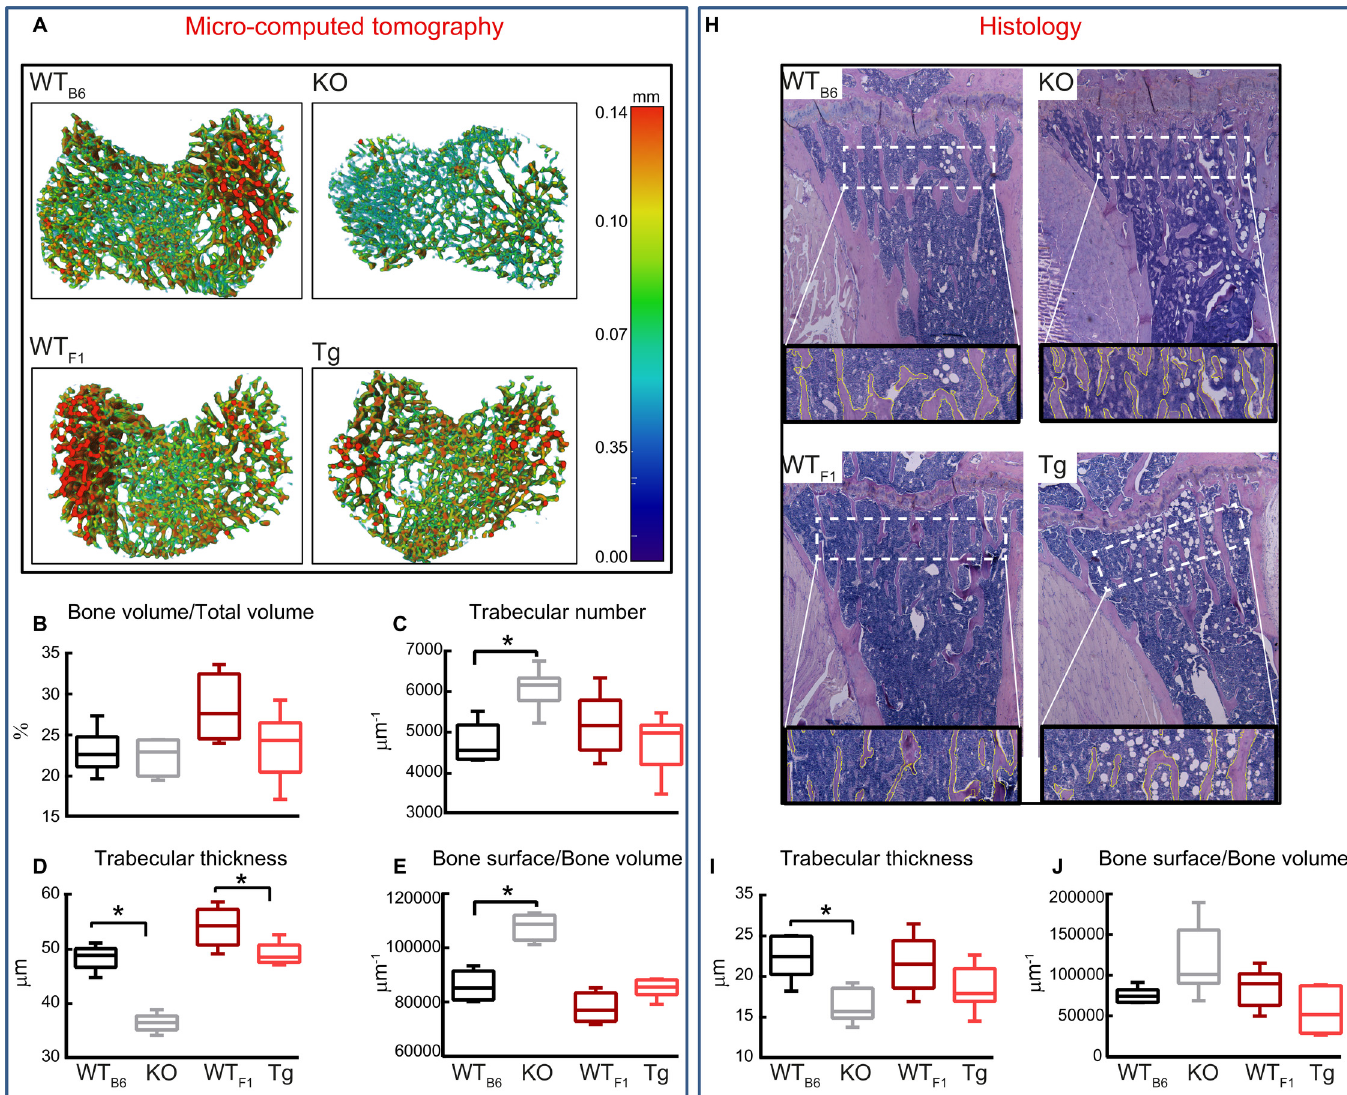
Fig 1. Deficiency and also transgenic overexpression of Timp-3 generate defects in trabecular bone. Trabecular bone phenotype of WT B6 (black), Timp-3 Tg (light red) tibia at 8 weeks of age. ( A ) Representative 3D Micro-CT thickness colour-coded images of tibial Timp-3 KO (grey), WT F1 (dark red), trabecular bone. Ex vivo high-resolution analyses of distal proximal metaphysical tibia to determine ( B ) trabecular bone volume/total volume, ( C ) trabecular number, ( D ) trabecular thickness and ( G ) bone surface/bone volume. ( H ) Representative Alcian blue haematoxylin and orange G/eosin stained sections with outline of trabeculae showing the region of interest used for measurements. These sections were analysed using Osteoid Histo to provide ( I) trabecular thickness and (J) trabecular bone surface/bone volume. Box-plots represent means ± SEM. Group sizes for Micro-CT (B-G) were n = 5 for WT littermates and n = 6 for Timp-3 KO and Tg mice. Group sizes for histological data (I-L) were n = 4 for all groups. Two-sample t-test was used to compare means between KO and WT B6 , and between Tg and WT F1 . Normality of variance assumption was violated for total area of KO group ( E ) and homogeneity for trabecular thickness of WT vs . KO group ( I ) (p > 0.05), thus, for these groups Kruskal-Wallis test was performed. Statistical comparisons: * denotes p (cid:1) 0.05. doi:10.1371/journal.pone.0159657.g001 1. Toluidine blue staining : sections were stained with toluidine blue (0.1% in 0.1M solution of acetate buffer [pH 5.6]), mounted with DPX mounting medium and imaged using a DM4000B upright microscope and DC500 colour camera both controlled through Leica Application Suite software version 2.8.1 (Leica Microsystems, Milton Keynes, UK). Growth plate zones were identified based on cell morphology and organisation, measured and expressed as a proportion of the total growth plate width using ImageJ. All growth plate